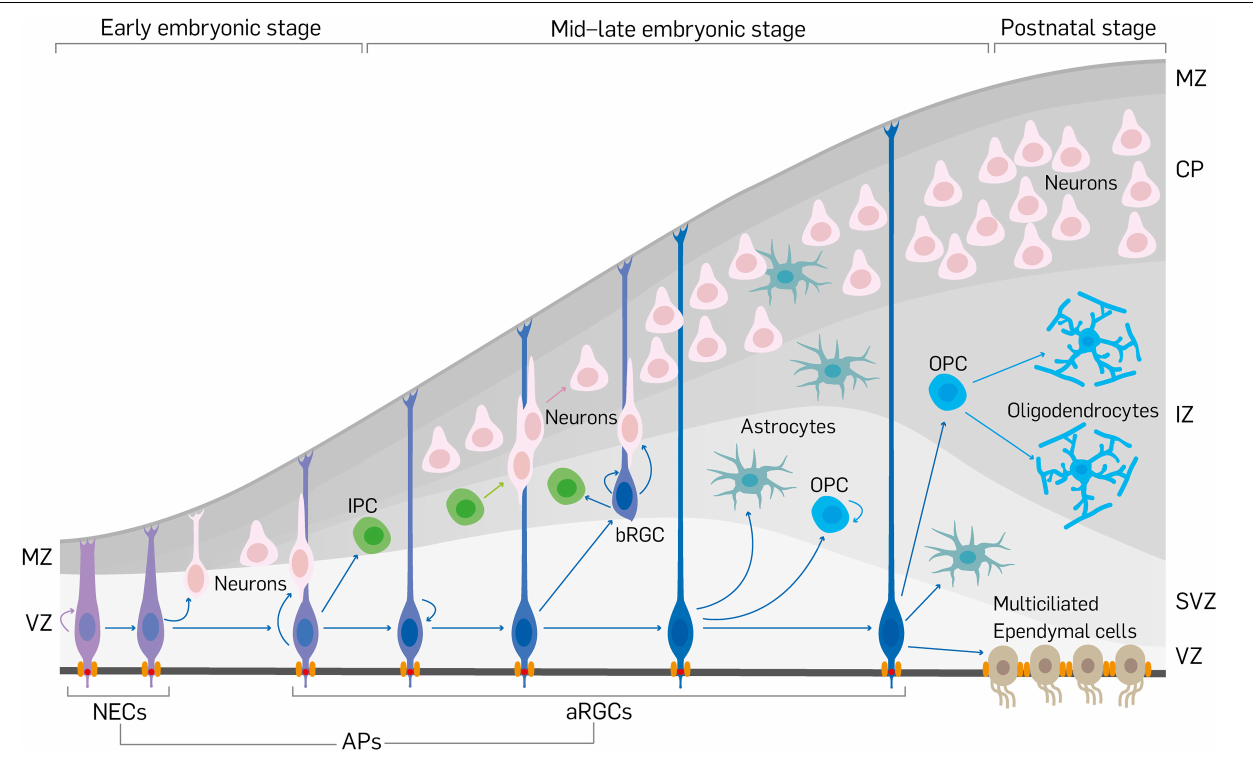
FIGURE 1 | Schema showing neurodevelopment in the mouse cerebral cortex. Early in cortical development, neuroepithelial cells (NECs) first expand their pool via proliferation and then transform into apical radial glial cells (aRGCs). Together, NECs and aRGCs make the apical progenitors (APs) in the developing cortex. Apical progenitors are anchored at the ventricular surface by apical junctional complexes, and also establish basal connection beyond the marginal zone (MZ) to make them have apicobasal polarity. Apical progenitors can produce limited number of neurons by direct neurogenesis. The neuronal pool is increased by indirect neurogenesis via the generation of neuron-amplifying cells such as intermediate progenitor cells (IPCs) and basal radial glial cells (bRGCs) by aRGCs. Newborn neurons migrate by somal translocation or by locomotion using the slender fibers of aRGCs as guides to exit the ventricular zone/subventricular zone (VZ/SVZ) and through the intermediate zone (IZ) to reach their destination in the cortical plate (CP). In the course of corticogenesis, aRGCs give rise to or transform into glial cells (astrocytes, oligodendrocytes or oligodendrocyte precursor cells [OPCs], ependymal